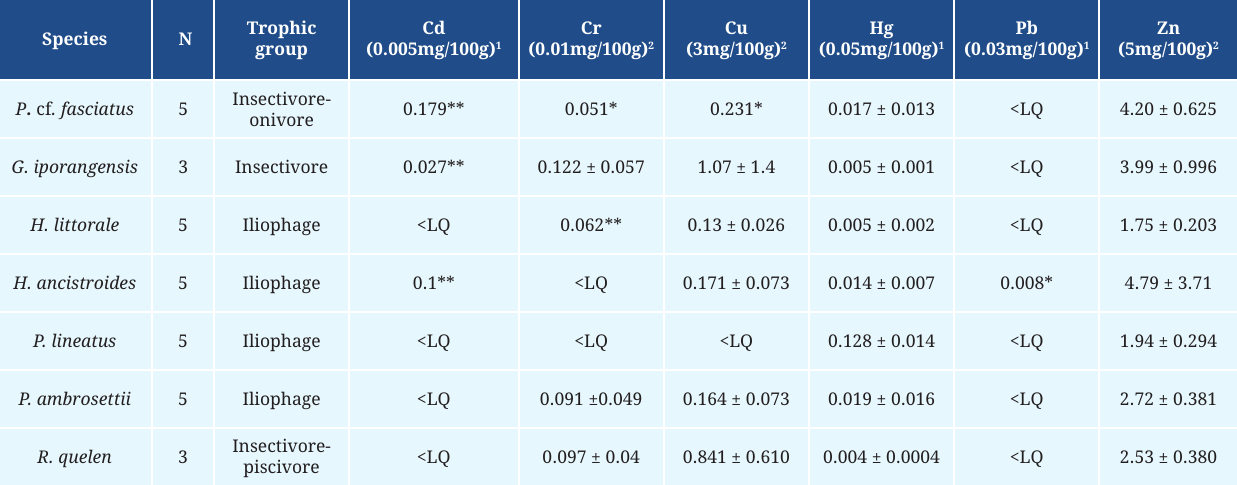
TABLE 2 | Concentration (mg/100g) of the metals considered in the study, for fish gill samples of the Sorocaba River. N: Number of analyzed samples; LQ: Limit of Quantification (Cd- 0.0250 mg/100 g. Cr-0.025 mg/100 g. Cu- 0.025 mg/100 g. Hg- 0.001 mg/100 g. Pb- 0.025 mg/100 g.